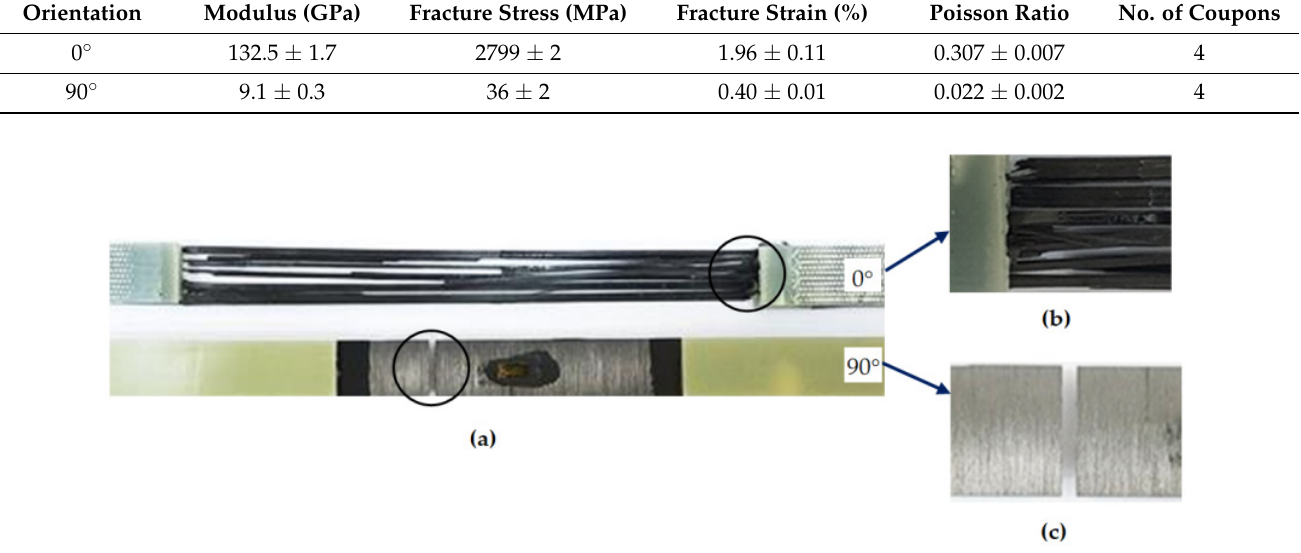
Figure 4. Tensile fracture modes for the 0° and the 90° coupons; ( a ) general view; ( b ) 0°; ( c ) 9°.